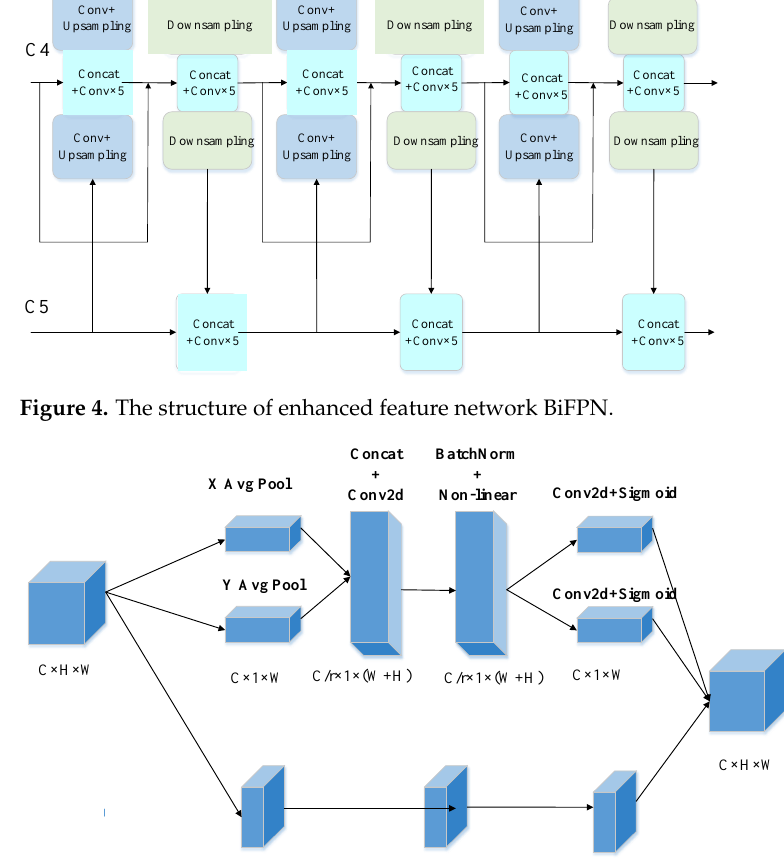
Figure 5. The network structure of coordinate attention mechanism.